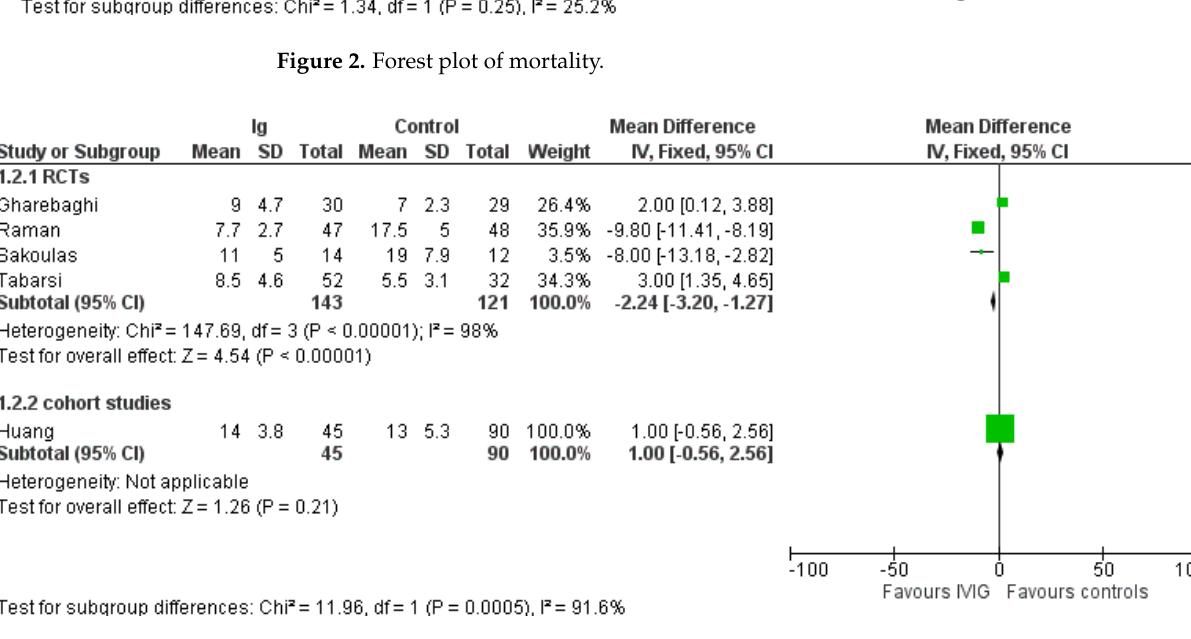
Figure 3. Forest plot of length of hospital stay.